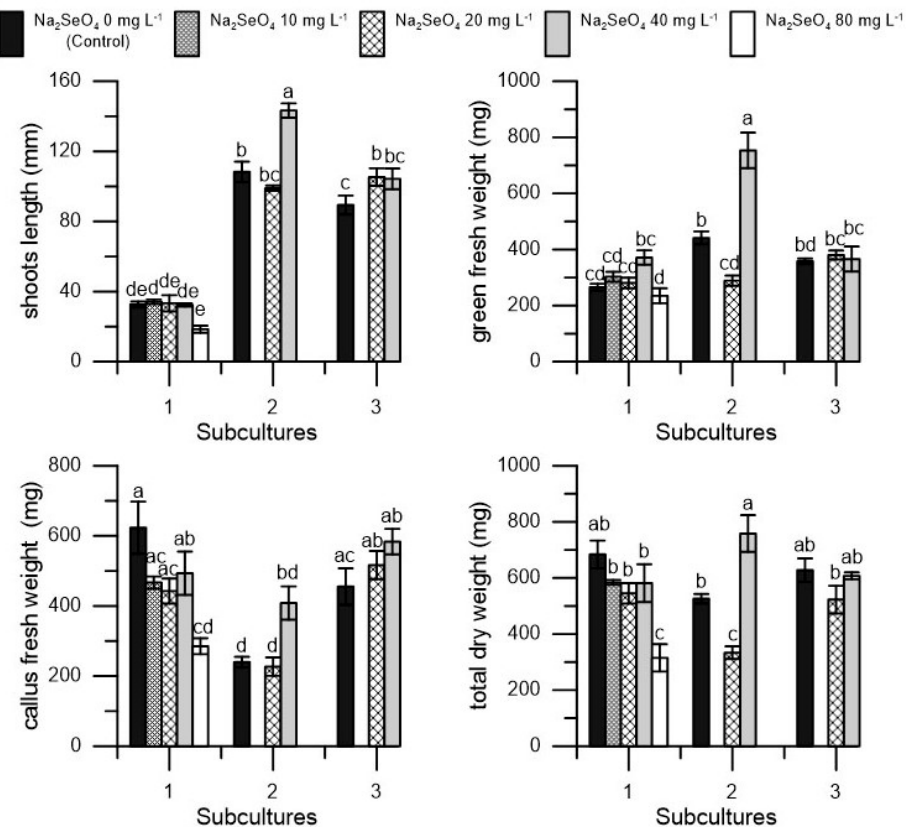
Figure 4. Shoot length (mm), green fresh weight (mg), callus fresh weight, and total dry weight (mg) in ‘Canino’ cv. in three different subcultures (1, 2, and 3) at five dosages of Na 2 SeO 4 (0, 10, 20, 40, and 80 mg L − 1 ) during the first subculture and at three dosages of Na 2 SeO 4 (0, 20, and 40 mg L − 1 ) during the second and third subculture. Each value represents the average of three replicates ± SEM. Mean values followed by different letters are significantly different ( p < 0.05).